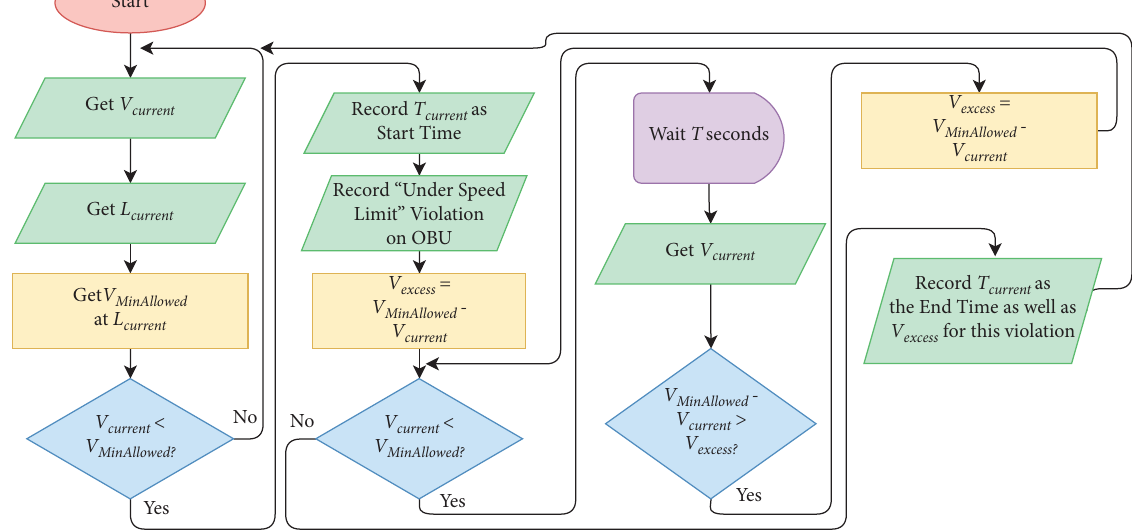
Figure 6: Flowchart of underspeeding violation detection using the OBU (simplifed fowchart of Algorithm